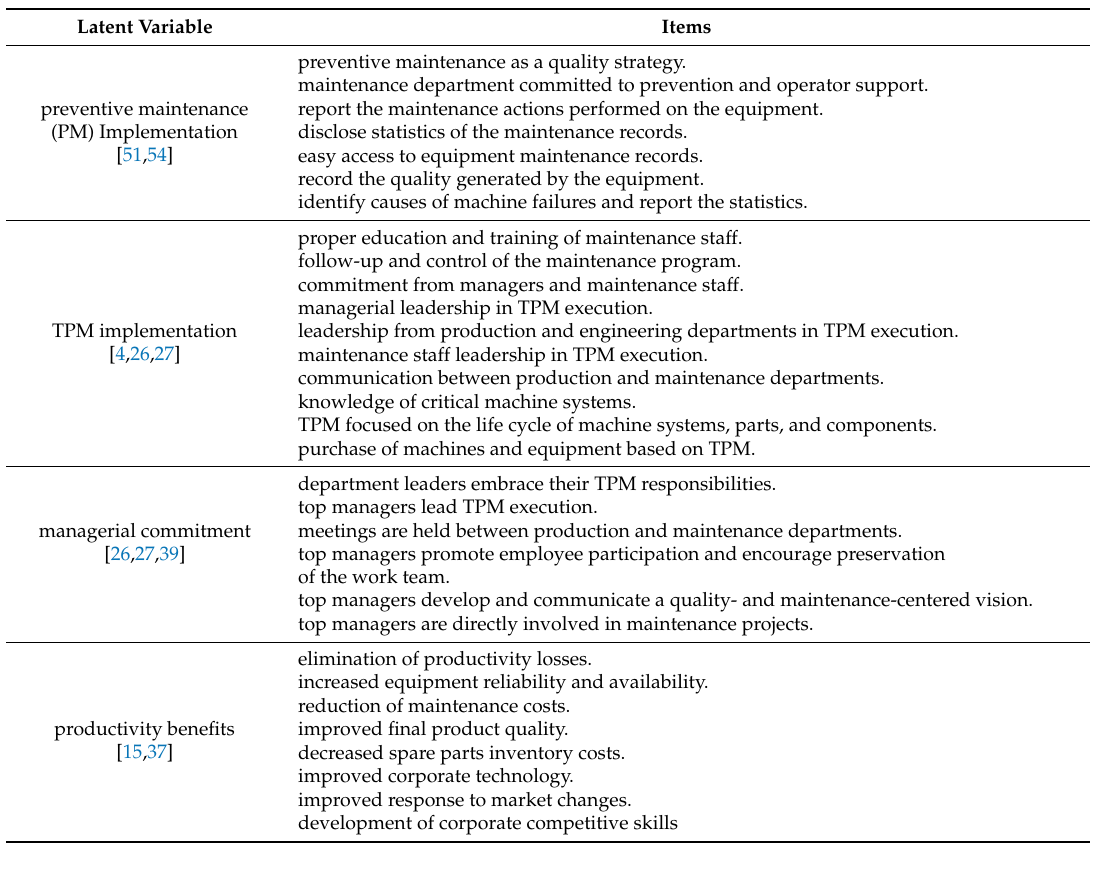
Table 1. Total productive maintenance (TPM) critical success factors and productivity